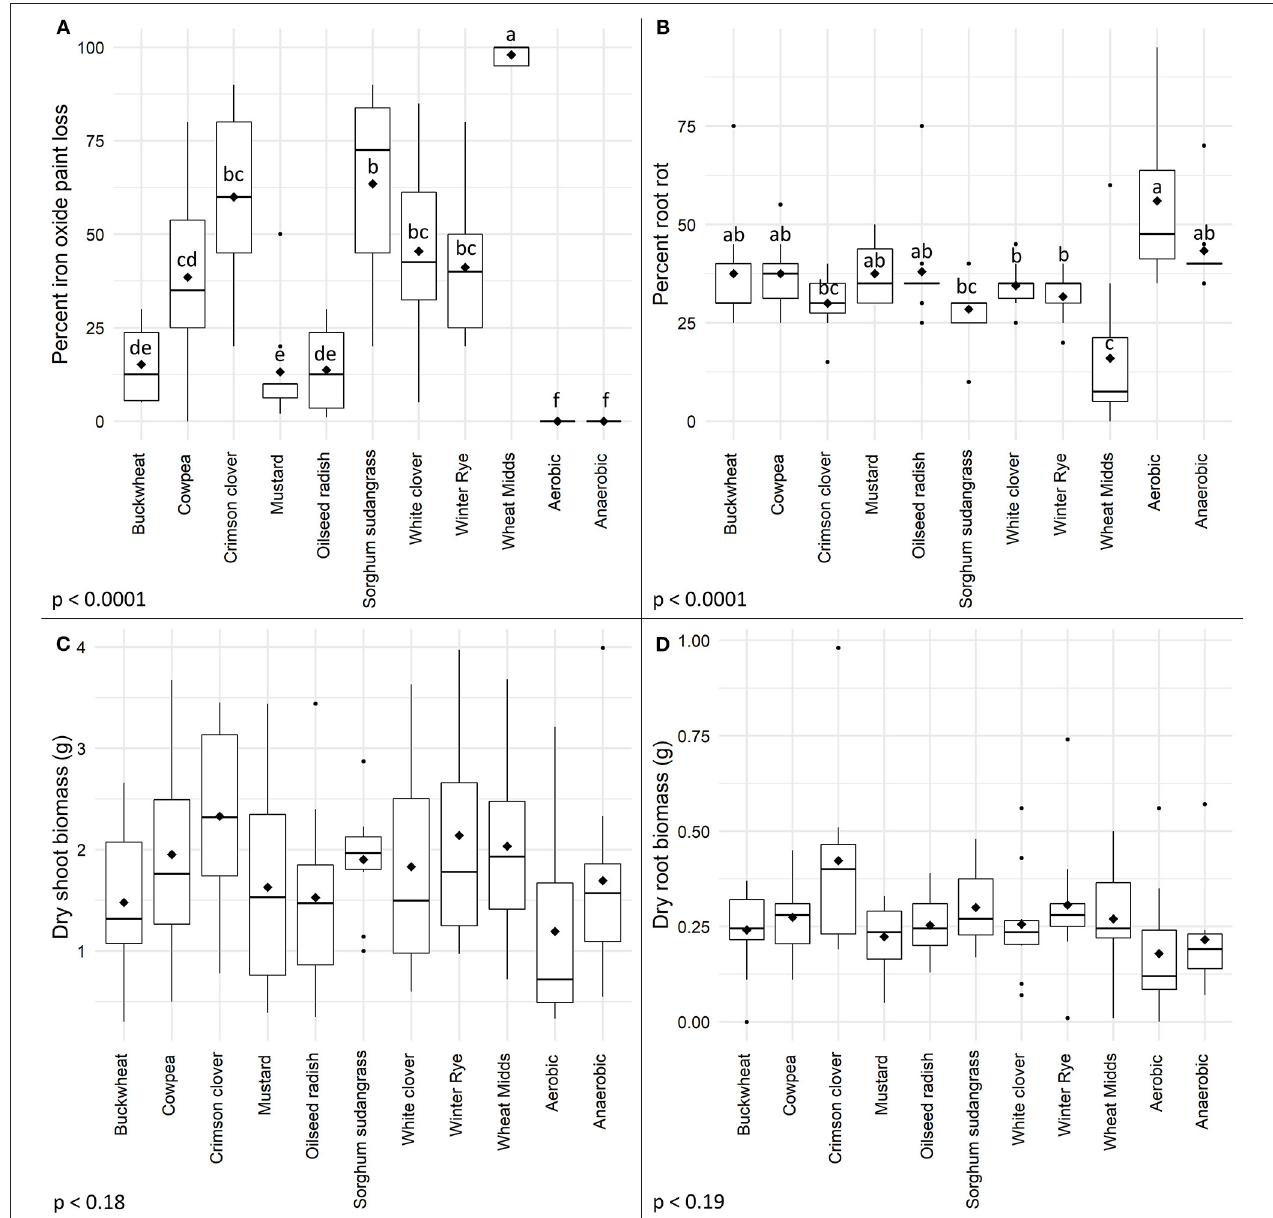
FIGURE 3 | Effects of cover crops as anaerobic soil disinfestation carbon sources on (A) soil reducing conditions as indicated by iron oxide paint loss on IRIS rods, (B) root rot severity, (C) dry shoot biomass and (D) dry root biomass. Cover crop ASD treatment (20.2 Mg/ha) amendment rates were compared to aerobic and anaerobic controls and a standard ASD treatment with wheat midds amendment. Treatments means are indicated by diamonds and means that do not share the same letters differ significantly based on Tukey’s HSD with a 95% family-wise confidence